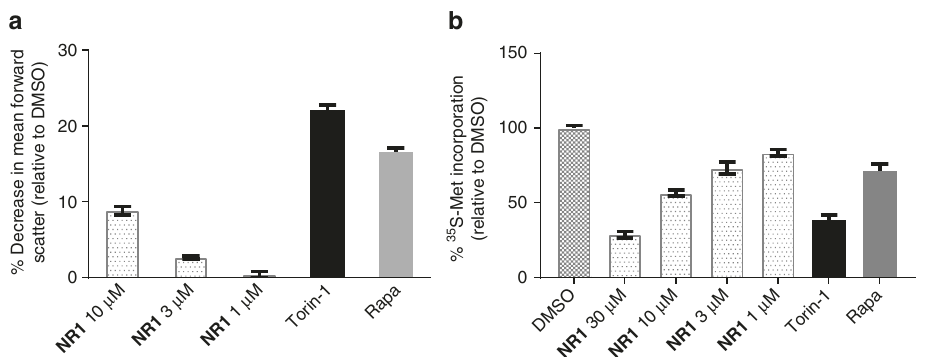
Fig. 5 Functional outcome of mTORC1 inhibition by NR1 . a Assessment of NR1 effect on cell size in Jurkat cells compared to Torin-1 and rapamycin. Jurkat cells were treated with NR1 over the indicated concentration range, Torin-1 (250 nM), or rapamycin (100 nM) for 48 h, and cell size was quanti fi ed as a measure of forward scatter using fl ow cytometry. Data are plotted as percent decrease in forward scatter. Error bars represent standard deviation of the mean of quadruplicates; graph represents data from one of three separate experiments. b Evaluation of NR1 impact on protein synthesis compared to Torin-1 and rapamycin as measured by the incorporation of 35 S-methionine into total protein. MCF-7 cells were treated with NR1 at the indicated concentration range, Torin-1 (250 nM), or rapamycin (100 nM) for 2.5 h and labeled with 35 S-methionine for 0.5 h. Error bars represent standard deviation of the mean of duplicates; graph represents data from one of two separate experiments